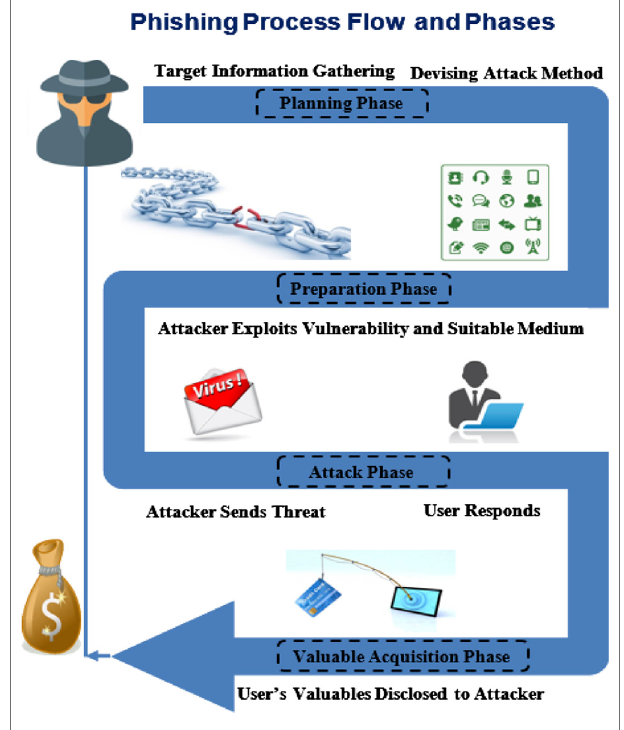
FIGURE 1 | General phishing attack